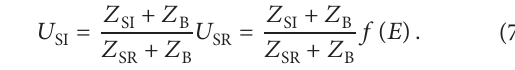
differential-mode current injection test method for system level EMC